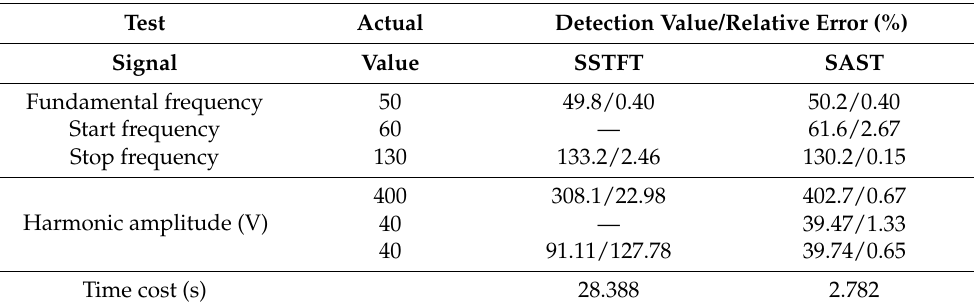
Table 7. Accuracy of two methods in detecting experimental interharmonic signals. Test